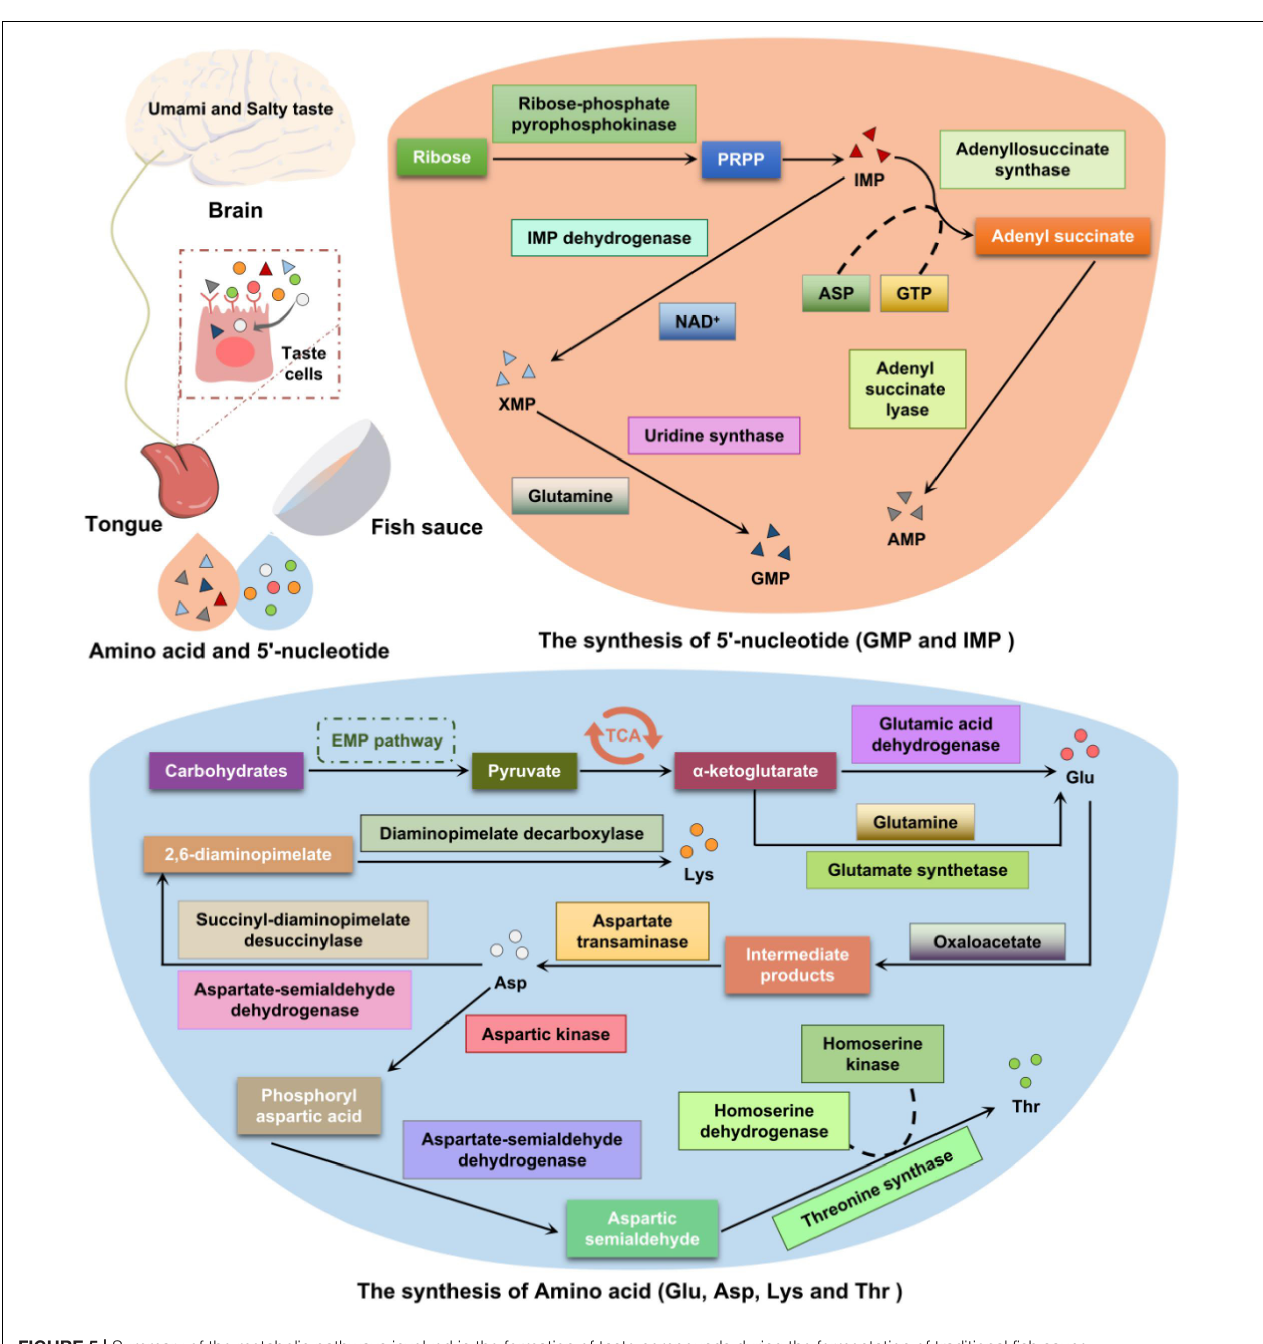
FIGURE 5 | Summary of the metabolic pathways involved in the formation of taste compounds during the fermentation of traditional fish